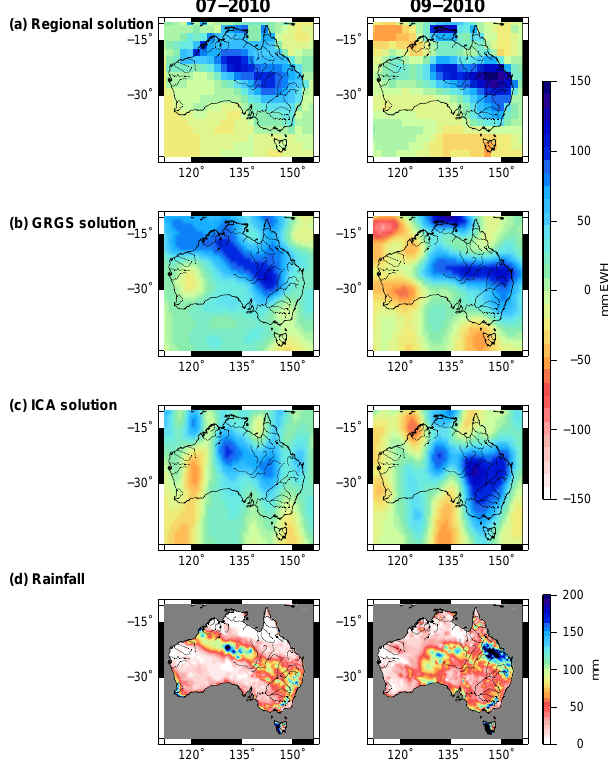
Fig. 12. Regional and GRGS RL02 of ∆ TWS monthly maps estimated with respect to the mean map for the previous driest season (from June to November 2009), and rainfall maps. For these two periods we notice that the regional solutions show a better localization of the exceptional rainfall maximum occurring in the central region of Australia. Table 3. Correlation values between climate index and PCA first 30 mode temporal patterns of regional, GRGS and ICA solutions.